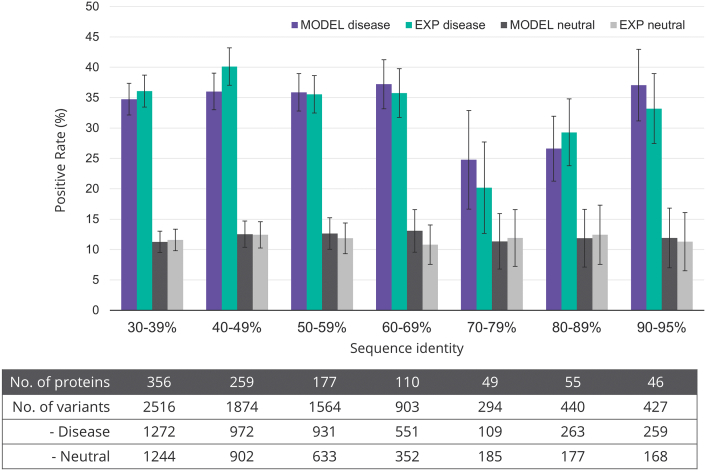
Performance of structural analysis on predicted models at different sequence identities. For each sequence identity bin, the fractions of positive predictions for the disease-associated and neutral variants are shown for both the predicted and the corresponding experimental structures. 95% Confidence intervals on the positive rates are shown as lines.